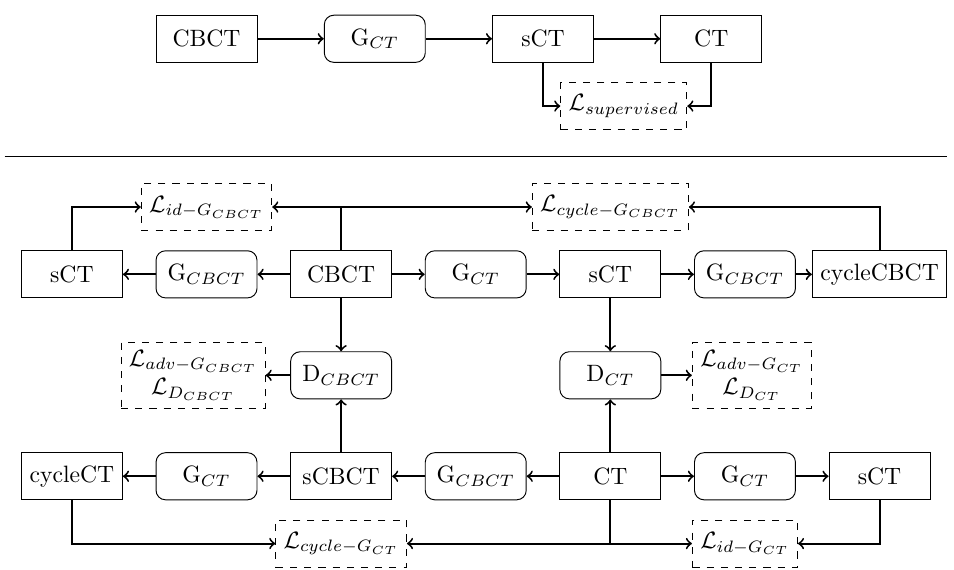
Figure 4. Schematic flow chart of supervised ( upper panel ) and unsupervised ( bottom panel ) training routines. Rectangle boxes represent images, and rounded corner boxes depict neural network models. Dashed boxes indicate a loss function. For a detailed explanation of the training routines, refer to the Appendix